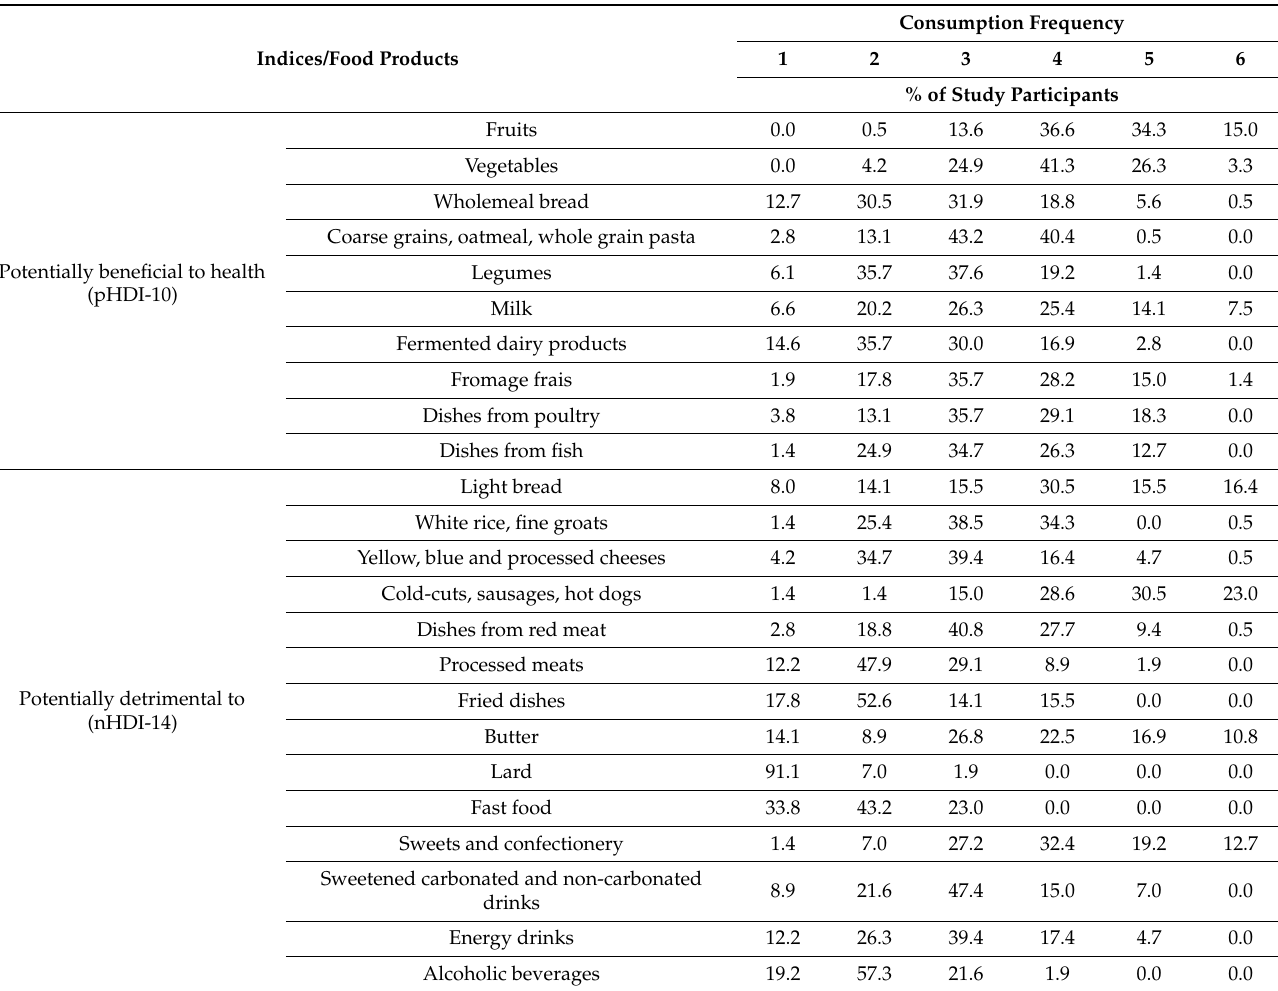
Table 1. Frequency of consuming products with potentially beneficial (pHDI-10) and potentially detri- mental (nHDI-14) impact on health among the surveyed athletes (N = 213) (percentage of respondents). Consumption Frequency 1 2 3 4 5 6 Indices/Food Products % of Study